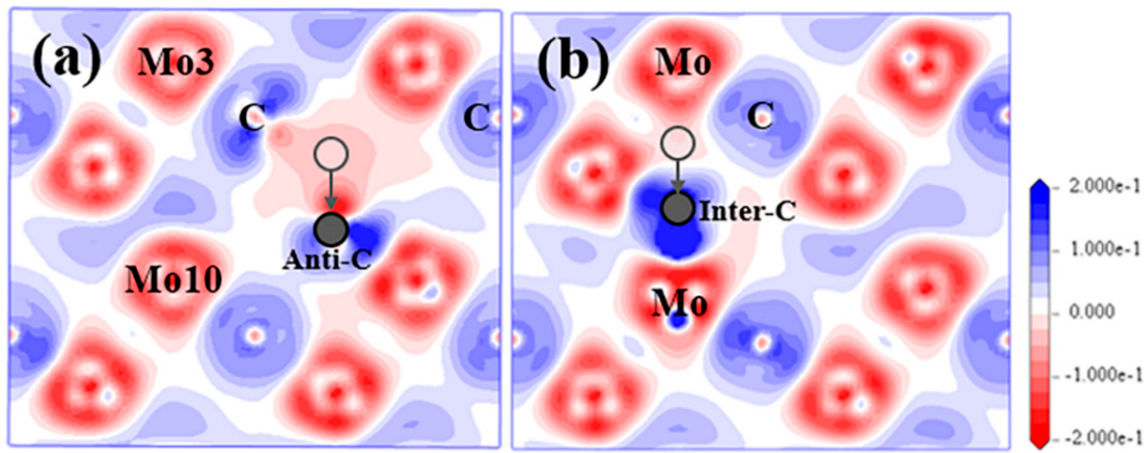
Figure 4. EDDD for Mo 2 C supercell with ( a ) S C and ( b ) I C (II) in (1 (cid:3364) 1 (cid:3364) 20) plane. Semitransparent grey balls represent the original position for C atom; Solid grey balls refer to the final position for defect C atom.